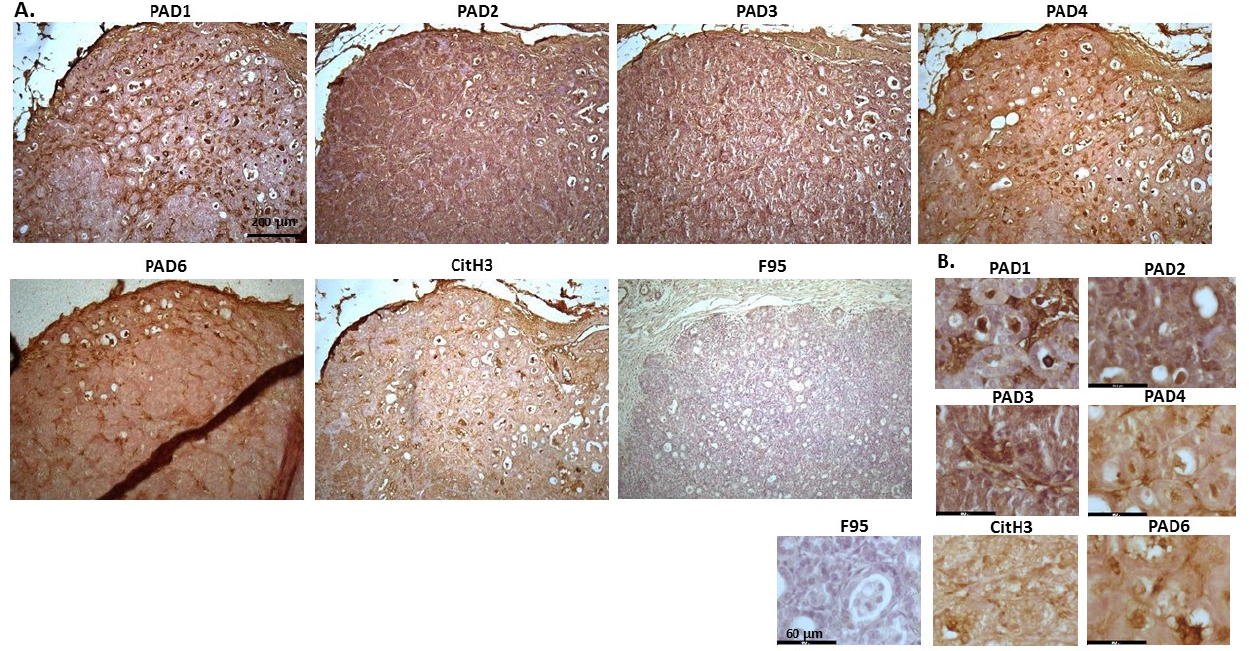
Figure 2. Rabbit, mammary adenocarcinoma. Biopsy from mammary gland of a four-year old female rabbit. ( A ) Overview images for PAD1, 2, 3, 4, 6, CitH3 and F95 stainings of serial tissue sections; scale bar represents 200 µ m for all images; 10 × objective. ( B ) Higher magnification shown for each staining from the images in ( A ); scale bar represents 60 µ m for all images; 40 × objective. Figure 3 shows a biopsy from mixed germ cell stromal tumour in a seven-year